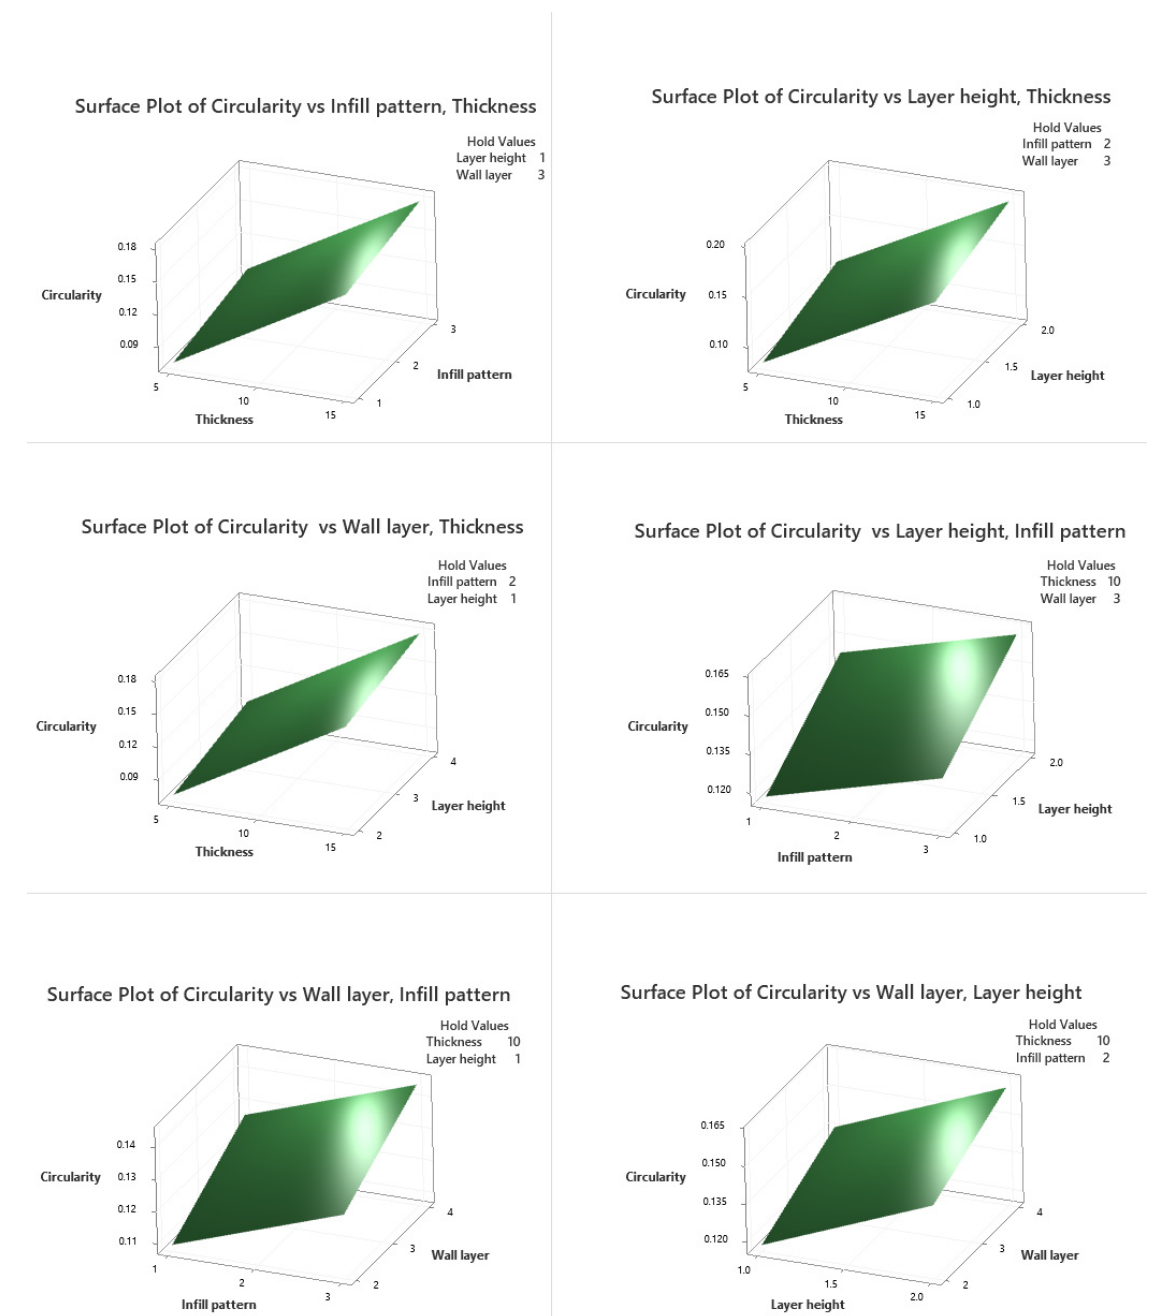
Figure 8. Circularity surface plots.